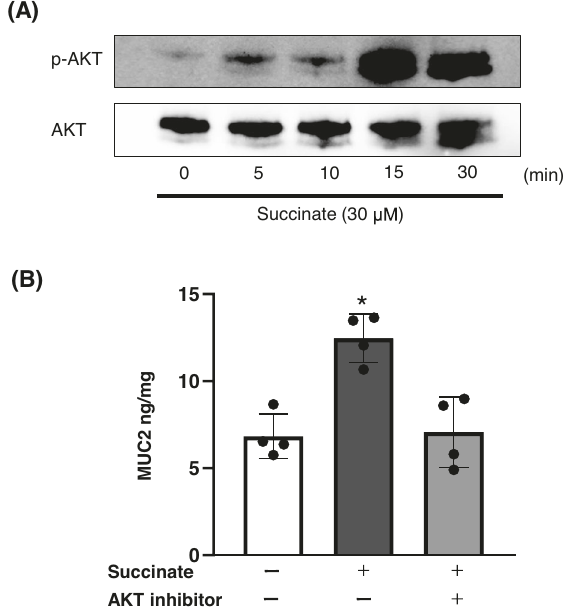
Fig. 6 AKT pathway in colon mucus production. A MUC2 protein expression on the control and succinate-transfected LS174T cells. B MUC2 protein in LS174T cells pretreated with 10 μ M of AKT inhibitor (perifosine) for 2 h and treated with succinate (* p < 0.05, vs.